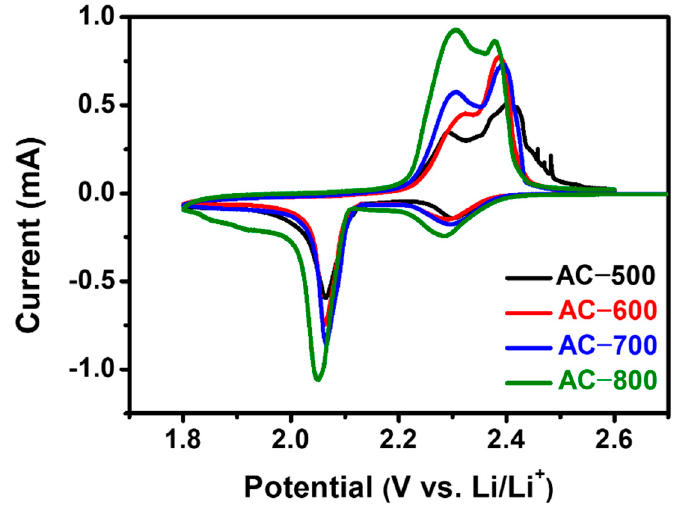
Figure 7. CVs of the AC samples measured in the potential range of 1.8–2.6 V vs Li/Li + at a scan rate of 0.01 mV s − 1 .